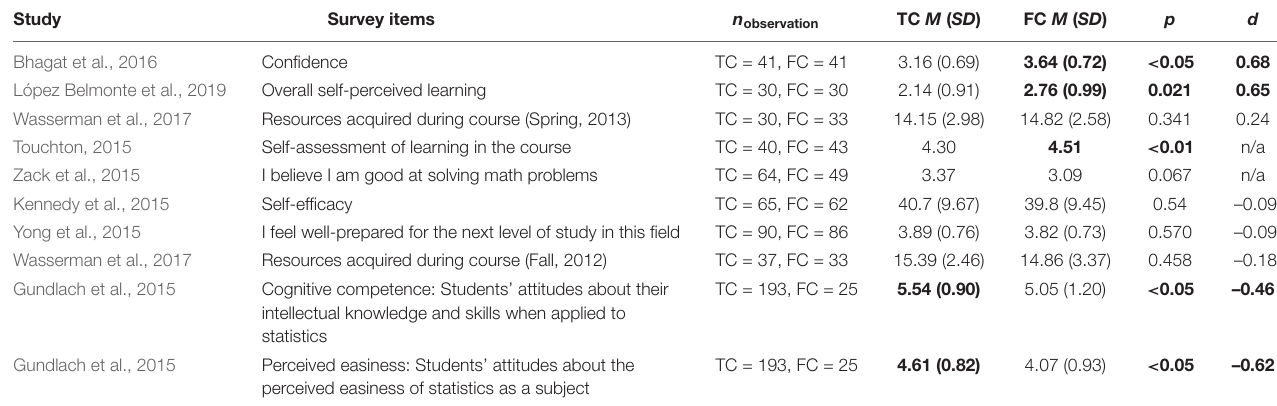
TABLE 7 | Survey results: Self-efficacy by effect size. Study